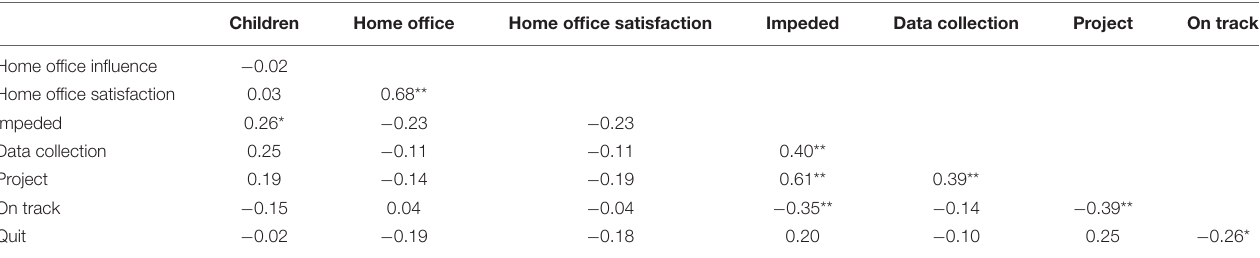
TABLE 3 | Project status and contextual factors : Spearman’s rank correlations.